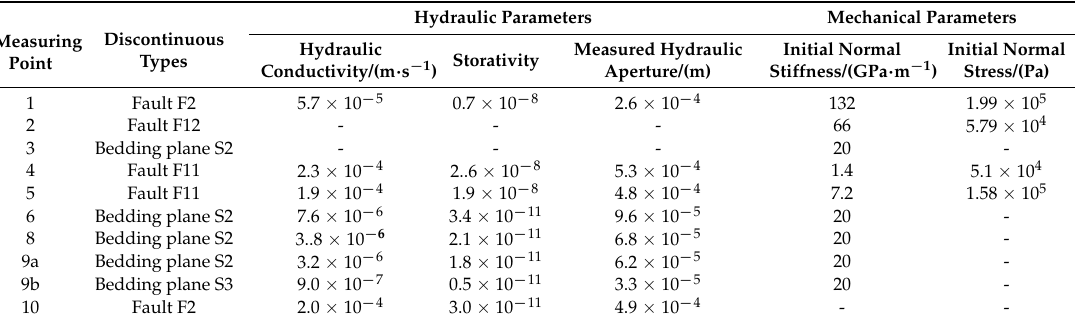
Table 1. Hydraulic and mechanical properties of the main discontinuities in French Alps test area [25].